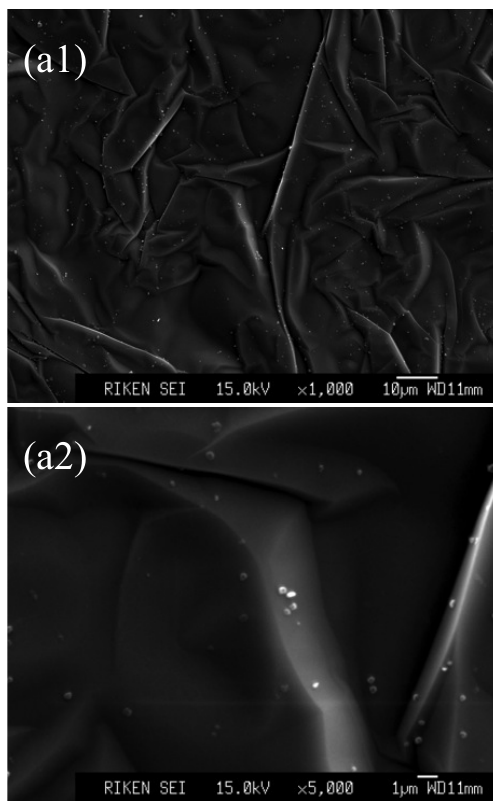
Fig. 2a. SEM images of the GS surface. (a1) and (a2): no- irradiated part.